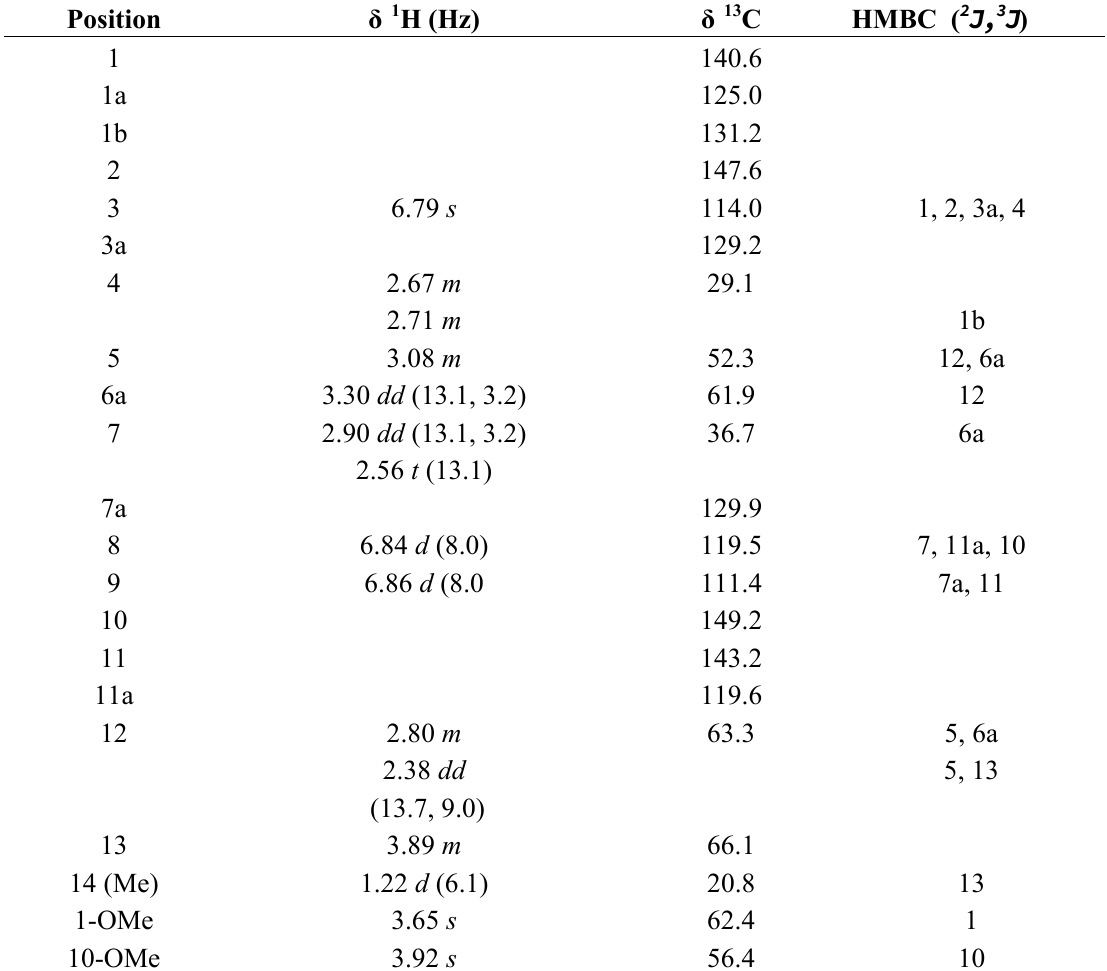
Table 1. 1 H-NMR (400 MHz) and 13 C-NMR (100 MHz) spectral data of compound 1 ( δ in ppm, J in in CDCl 3